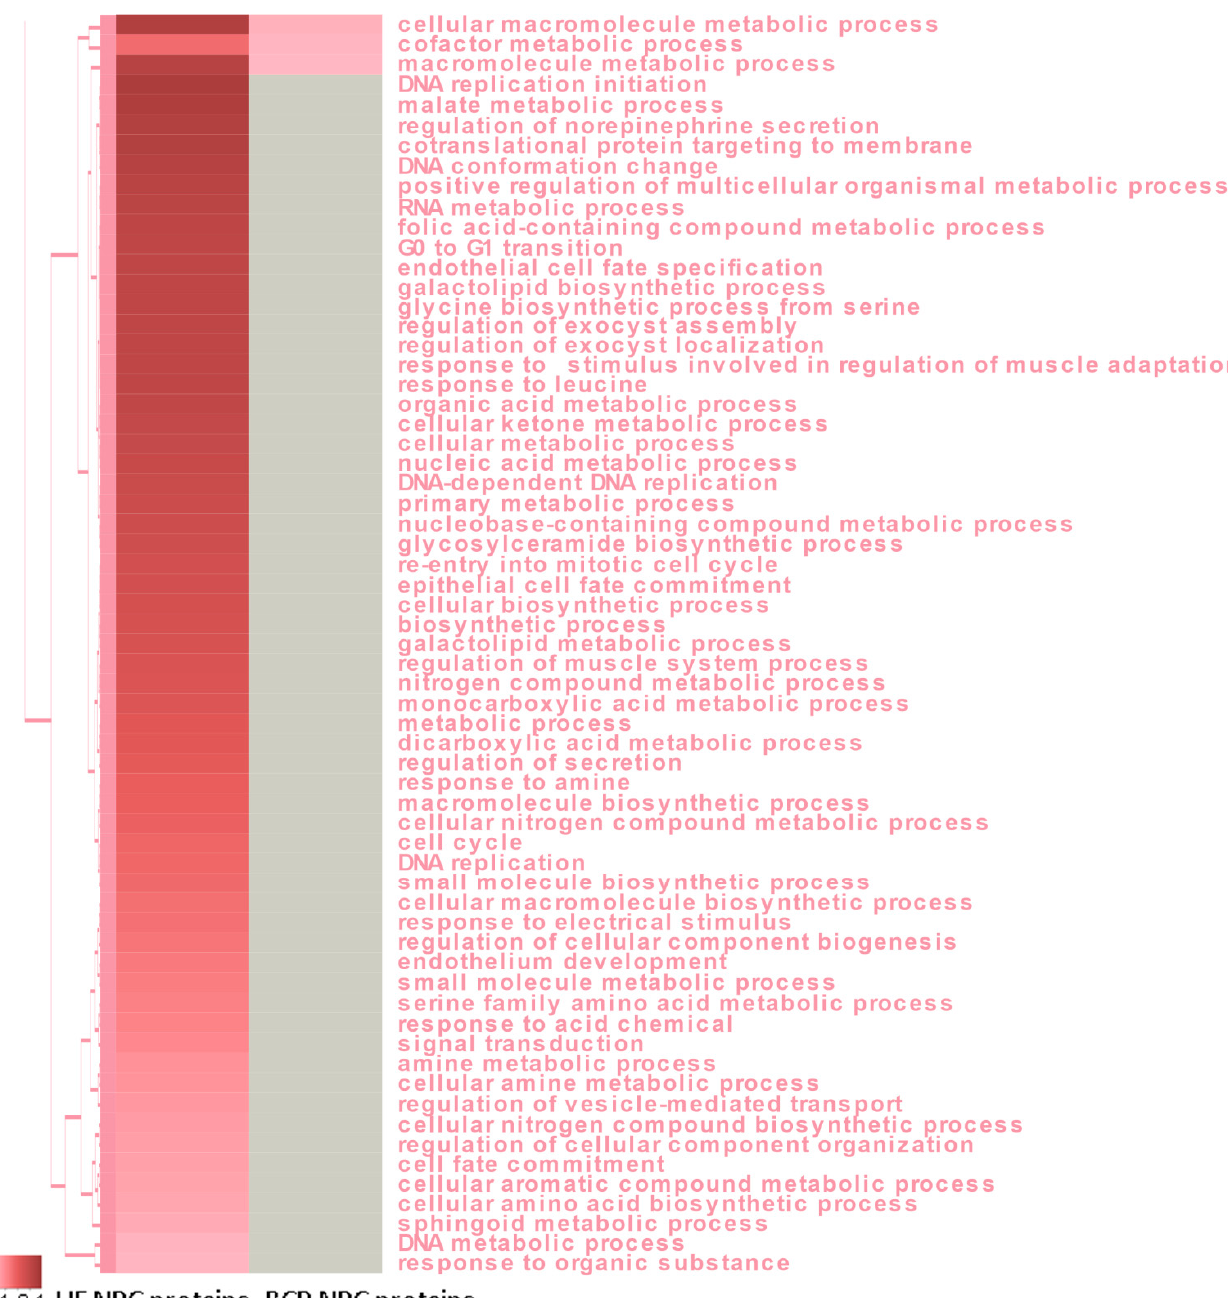
Figure 7. Heat map and dendrogram of the results of GO functional enrichment analysis of NPC proteins from BCPs and HFs by biological processes obtained via STRING (https://string-db.org/, accessed on 1 March 2023) and visualized using R (https://www.r-project.org/, accessed on 1 March 2023). GO results with p < 0.05 are shown as normalized − log ( p ) values.